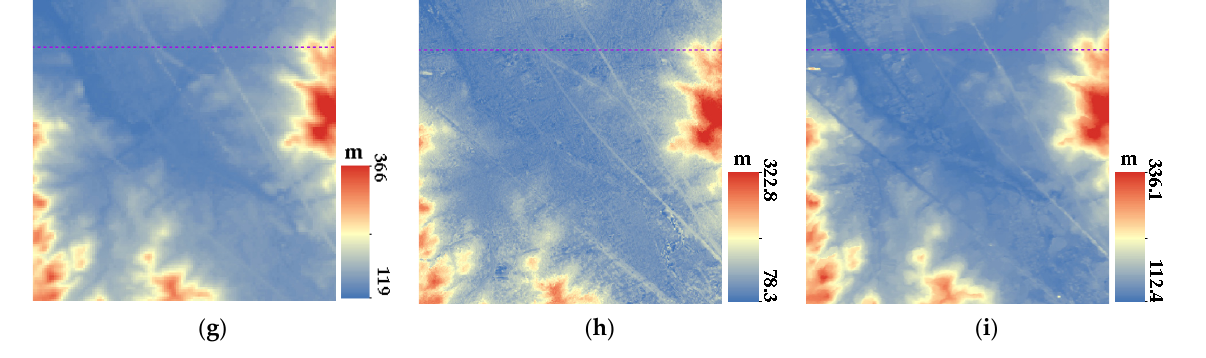
Figure 7. DSM of valley regions: ( a ) Reference DEM of valley region 1; ( b ) DSM extracted by ENVI of valley region 1; ( c ) DSM of this paper of valley region 1; ( d ) Reference DEM of valley region 2; ( e ) DSM extracted by ENVI of valley region 2; ( f ) DSM of this paper of valley region 2; ( g ) Reference DEM of valley region 3; ( h ) DSM extracted by ENVI of valley region 3; ( i ) and DSM of this paper of valley region 3.